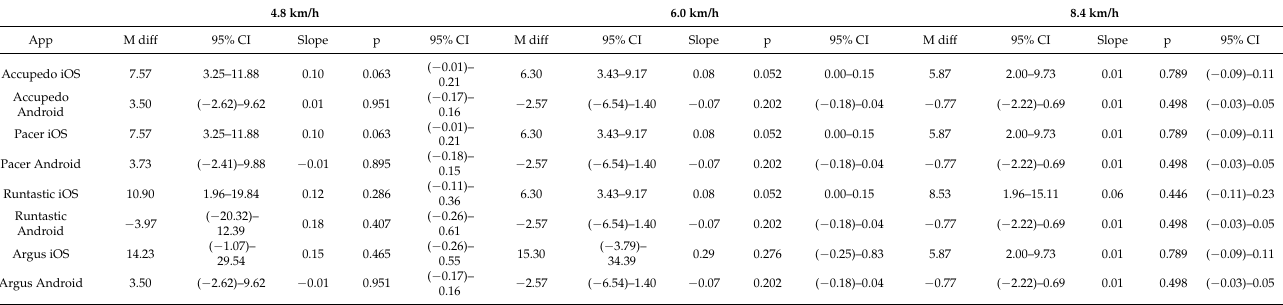
Table 3. Step count Bland–Altman results at various speeds.